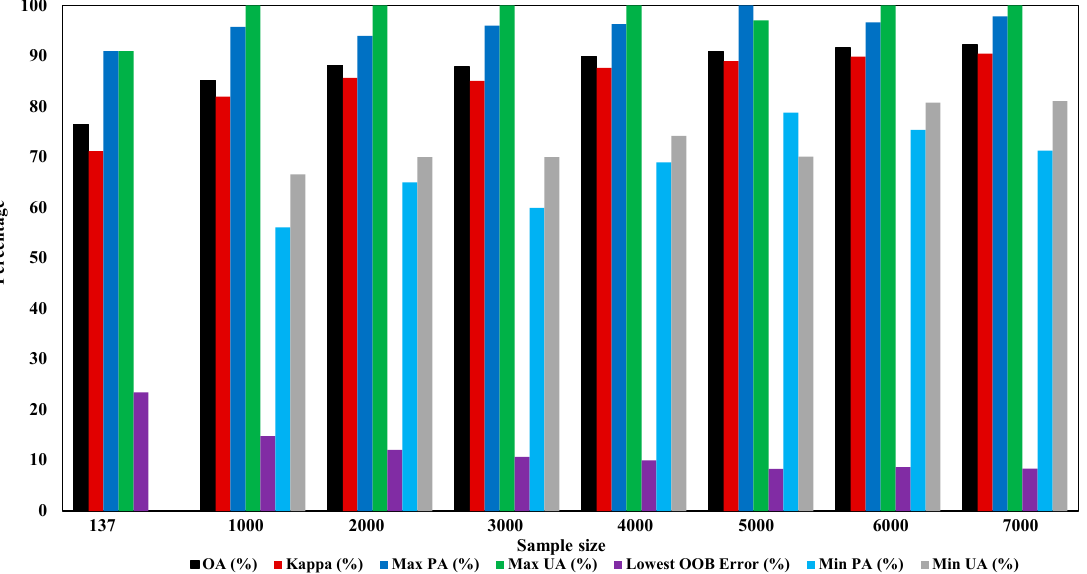
Figure 7. Effect of sample size on OA, UA, PA, kappa, and OOB error in RF classification.